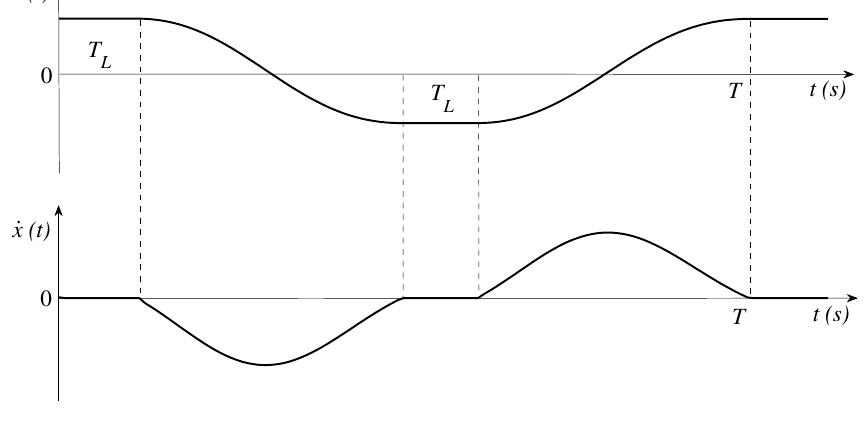
Figure 2. System variables under latching control